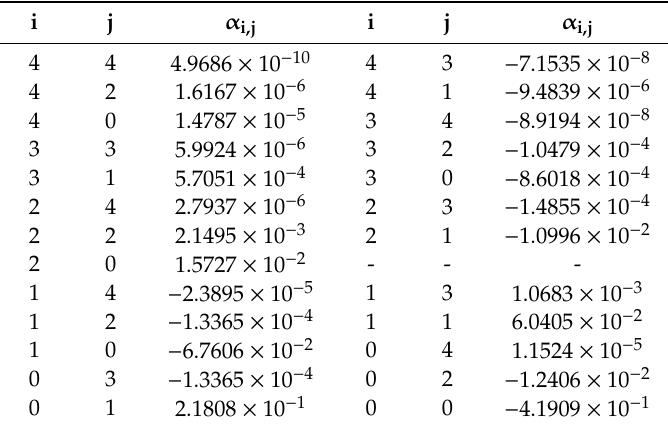
Table 1. Cp coefficients α i,j [21]. Table 1. Cp coe ffi cients α i,j [21].